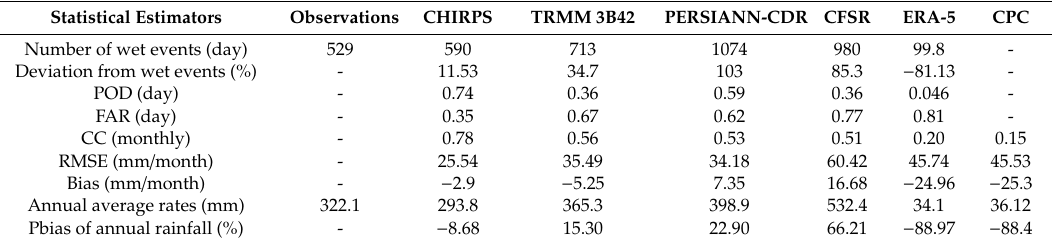
Table 9. Overall summary of the statistical result of the precipitation